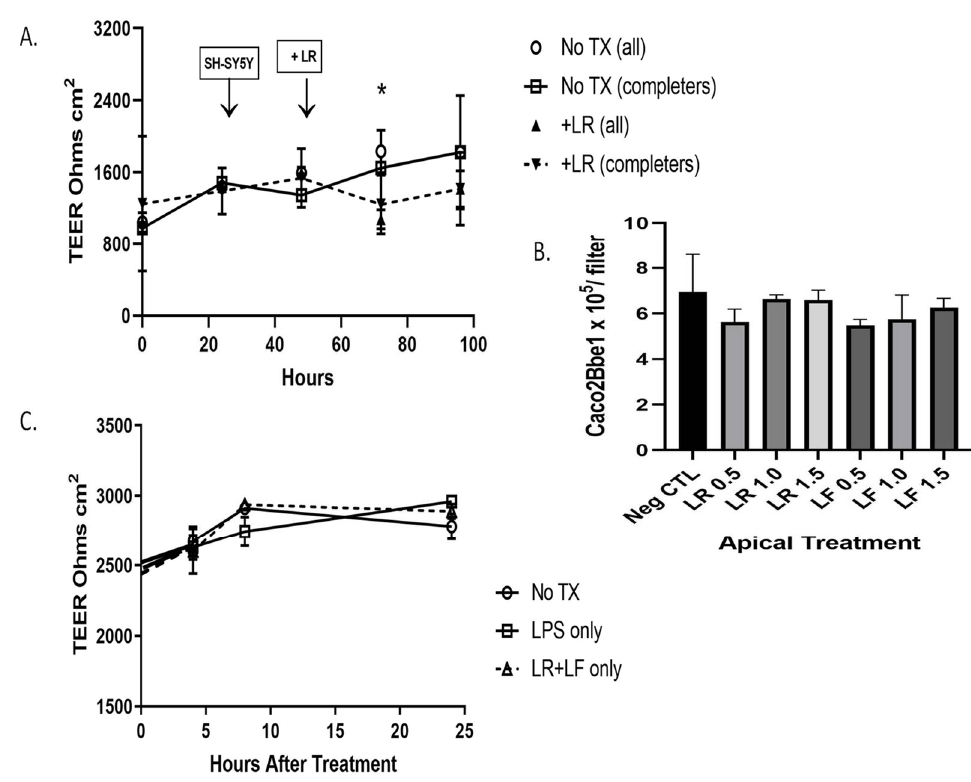
Figure 9. Status of Caco2Bbe1 cells during probiotic administration to the apical side of co-culture model. These studies began by plating n = 25,000 Caco2Bbe1 cells on inserts in a 24-well plate. Such were regularly refed (Figure S2). Eleven days after starting the inserts, a separate open-well plate was given SH-SY5Y cells ( n = 400) in complete (10% FBS) media. On day 14 after plating the inserts, the apical media was switched to media with 1% FBS (though basal media remained 10% FBS). On same day, the media in the open SH-SY5Y wells was replaced with fresh media lacking FBS (0%) but containing 10 µ M retinoic acid (RA). Both plates were returned to the incubator for 1 more day. Panel ( A ) shows TEER values from one day after open-well RA. The experimental Caco2Bbe1 inserts were transplanted atop SH-SY5Y cells (first arrow). A day after that, probiotic Lactobacillus rhamnosus (LR) was added atop the inserts, or, in the untreated case, no LR was added (just vehicle: 1% FBS media). Some of the starting inserts were harvested and counted before reaching the 190-h endpoint, which meant the data analysis was performed from start to finish in two ways: with “all” or “completer” wells. Panel ( B ) shows Caco2Bbe1 cell numbers counted from the inserts harvested at 190 h. The groups were either without probiotics, or with LR added at 0.5, 1.0, or 1.5 × 10 7 bacilli per insert, or with Lactobacillus fermentum (LF) added at 0.5, 1.0, or 1.5 × 10 7 bacilli per insert. Panel ( C ) shows another experiment in which TEER was followed for 24 h from when the probiotic was added (set up as in panel ( A )), except the experimental variables were without more additions, or with only lipopolysaccharides (LPS) added apically (0.5 µ g in 0.5 mL per well), or with a mixture of LR and LF added apically, each at 0.5 × 10 7 bacilli per 0.5 mL volume into the upper well of the insert (No LPS). The plots are means ± SEMs. * Comparing TEER in panel ( A ), with LR versus without LR (all), p = 0.033 when adjusted for multiple unpaired t tests. No other comparisons were statistically significant in any of the